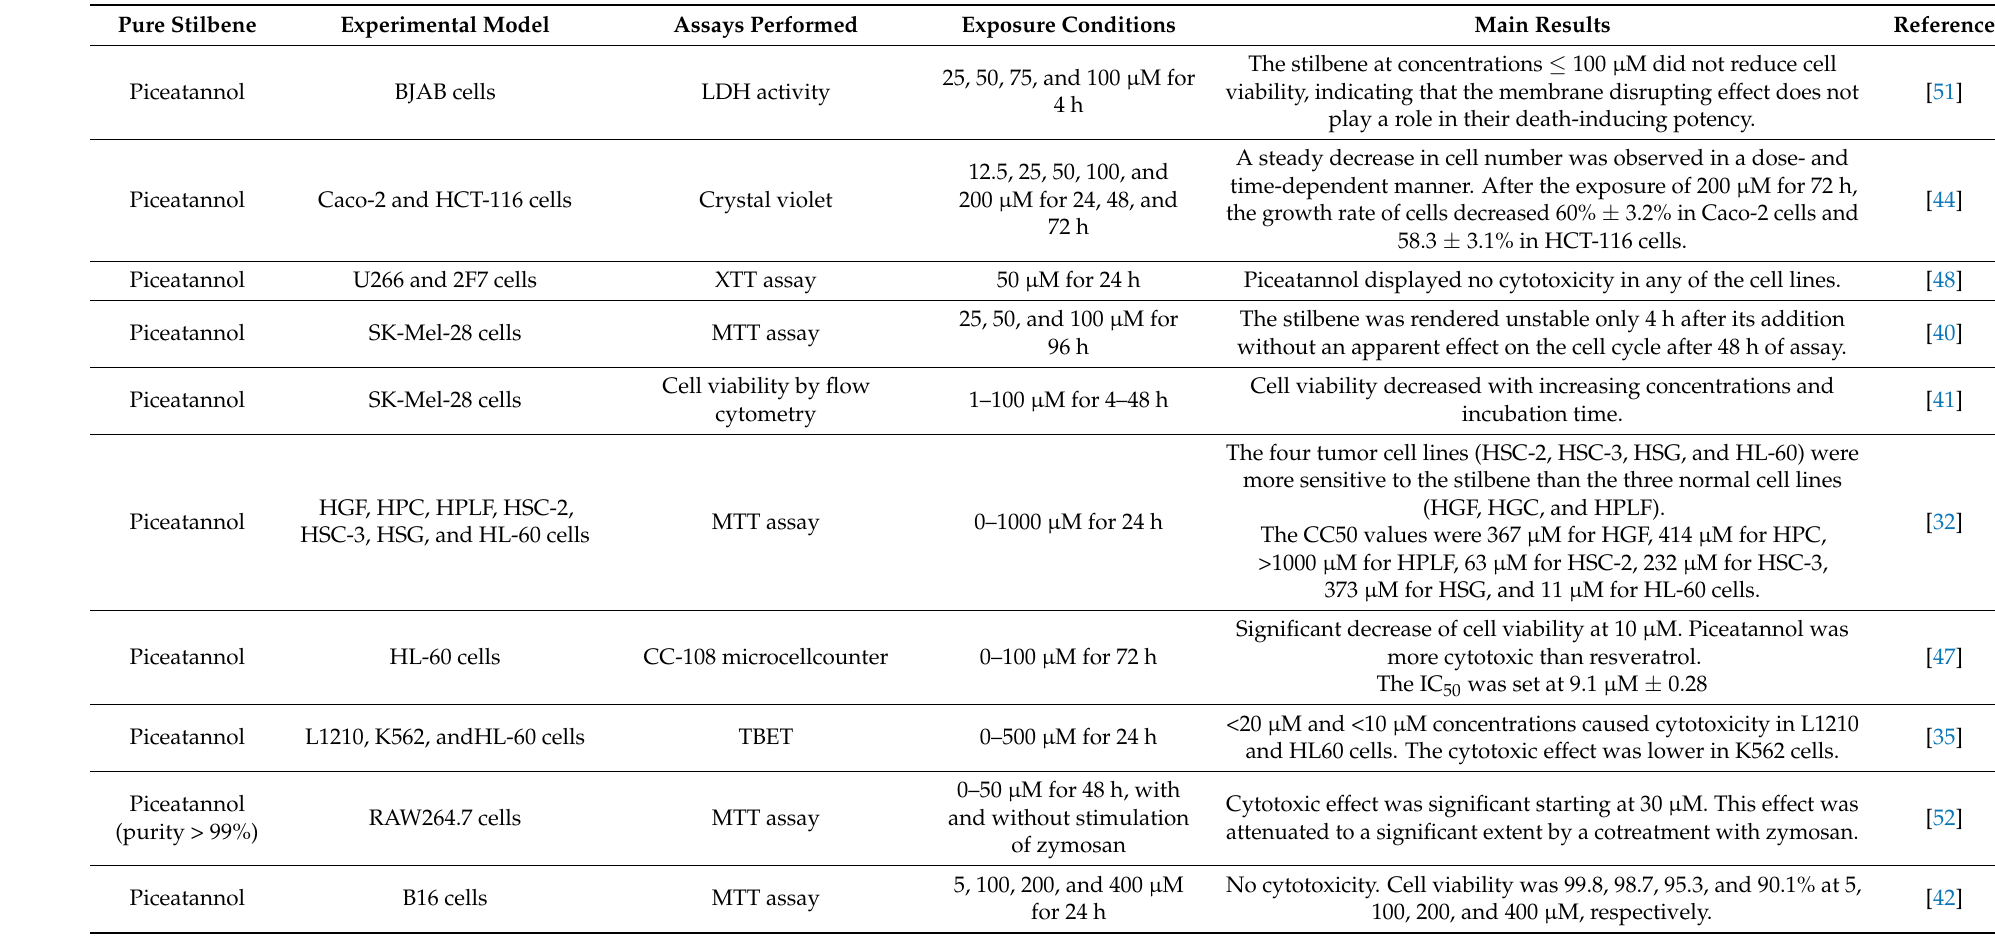
Table 1. In vitro cytotoxicity studies performed with